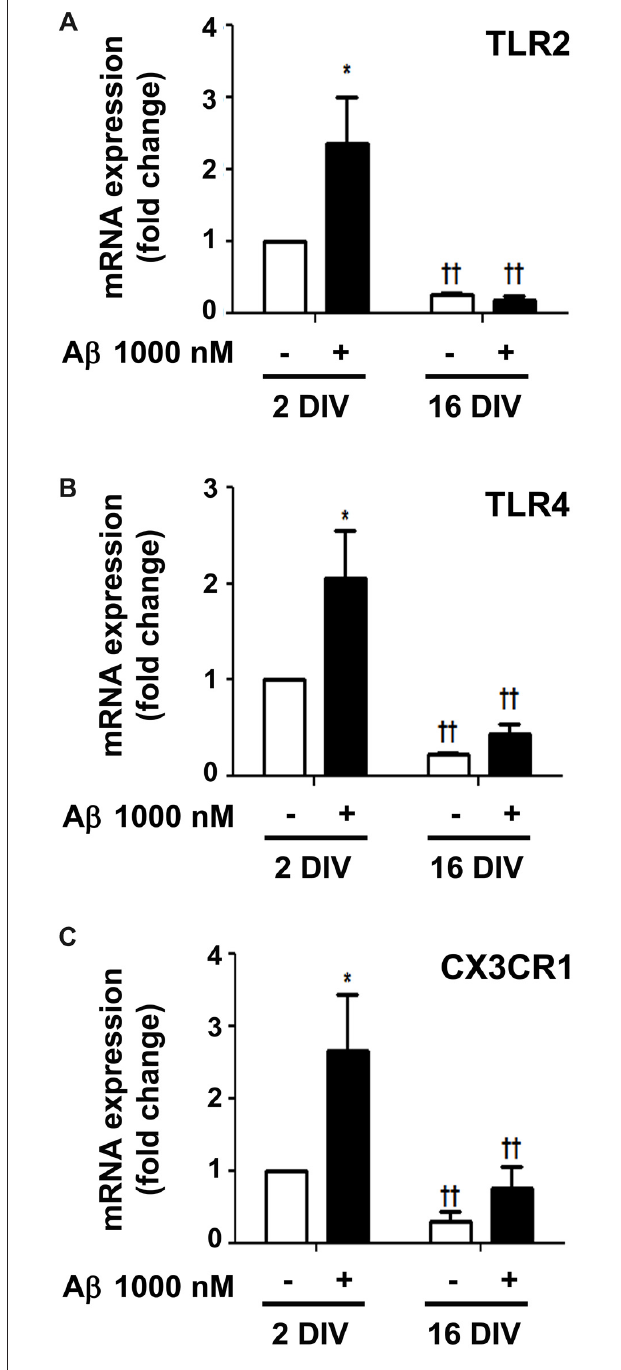
FIGURE 9 | Amyloid- β (A β ) peptide upregulates the expression of Toll-like receptor 2 (TLR2), TLR4 and fractalkine/CX3C chemokine receptor 1 (CX3CR1) in the reactive cultured microglia, but not in aged cells. Microglia that were kept in culture for 2 and 16 days in vitro (DIV) were treated with 1000 nM A β for 24 h. Expression of TLR2 (A) , TLR4 (B) and CX3CR1 (C) was evaluated by Real-Time PCR. Results are expressed in graph bars as mean ± SEM. Cultures, n = 4 per group. Two-way ANOVA ( Post hoc Bonferroni test): ∗ p < 0.05 vs. respective non-treated Control; †† p < 0.01 vs. 2 DIV cells; (A) DIV × A β interaction F ( 5.29 ) , p <